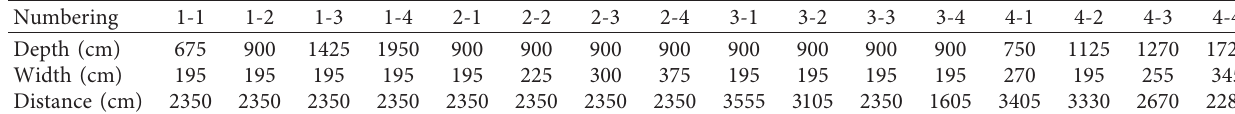
Table 2: Damping ditch size of each model.